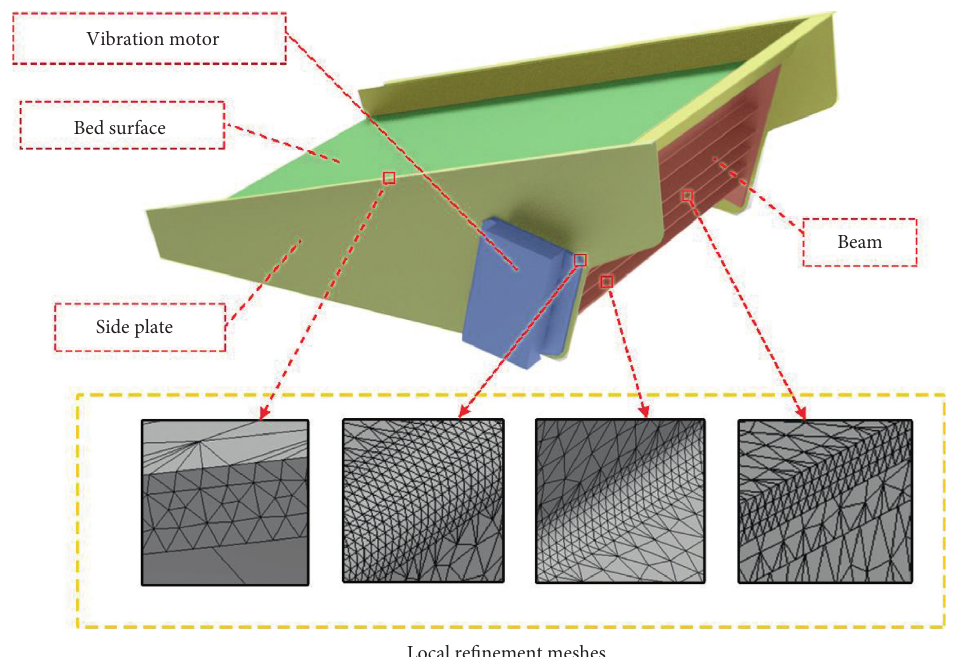
Figure 4: Local refinement meshes and the simplified model of vibrating feeder.